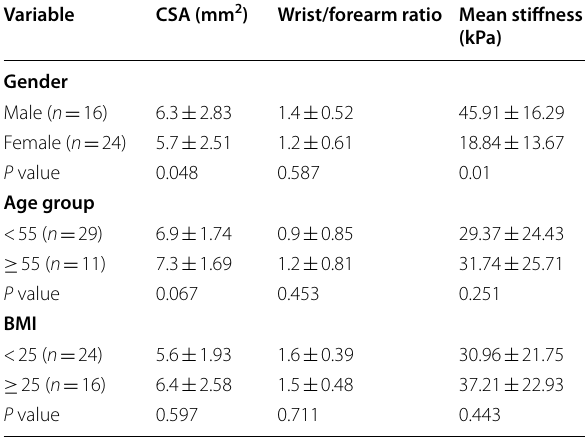
Table 5 Quantitative analysis of CSA of median nerve, wrist/ forearm ratio and mean stiffness (elasticity) between controls